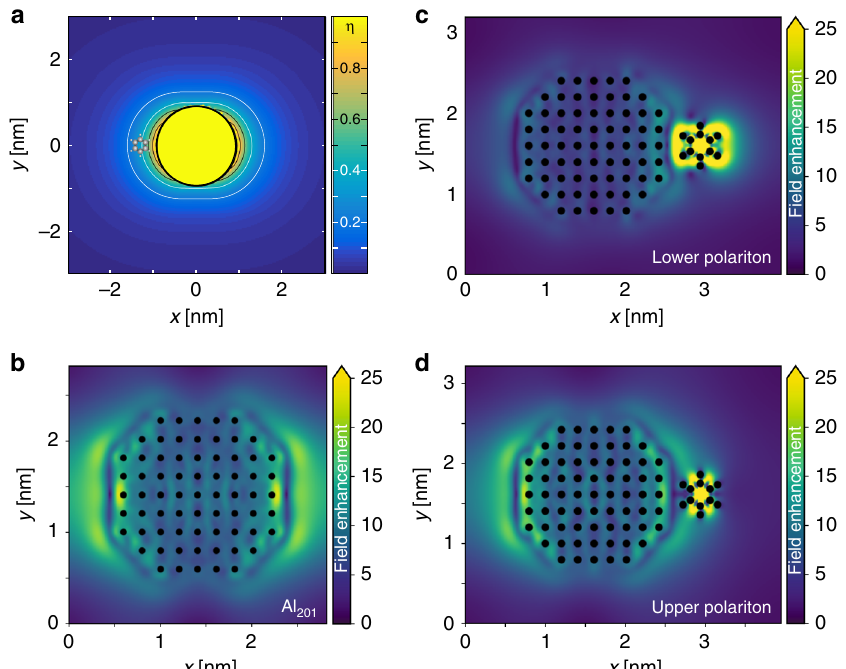
Fig. 4 Coupling ef fi ciency and electric near- fi eld enhancement in Al 201 . a Spatial map of the coupling ef fi ciency (normalized mode energy density, calculated using classical electromagnetism) shows that maximum coupling occurs if the benzene molecule is inside the Al 201 particle and decreases rapidly away from its surface. At the position of benzene the coupling ef fi ciency is about 30 – 50% of the maximum value. The contours are spaced every 0.2. b – d Field enhancement from time-dependent density-functional theory calculations at ( b ) the Al 201 resonance and at the Al 201 -benzene ( c ) lower and ( d ) upper polaritons (with benzene located at the center of the facet). Benzene focuses the electric fi eld, perturbing the nanoplasmonic cavity and increasing the coupling ef fi ciency beyond the expectation based on the fi eld at the bare resonance 52